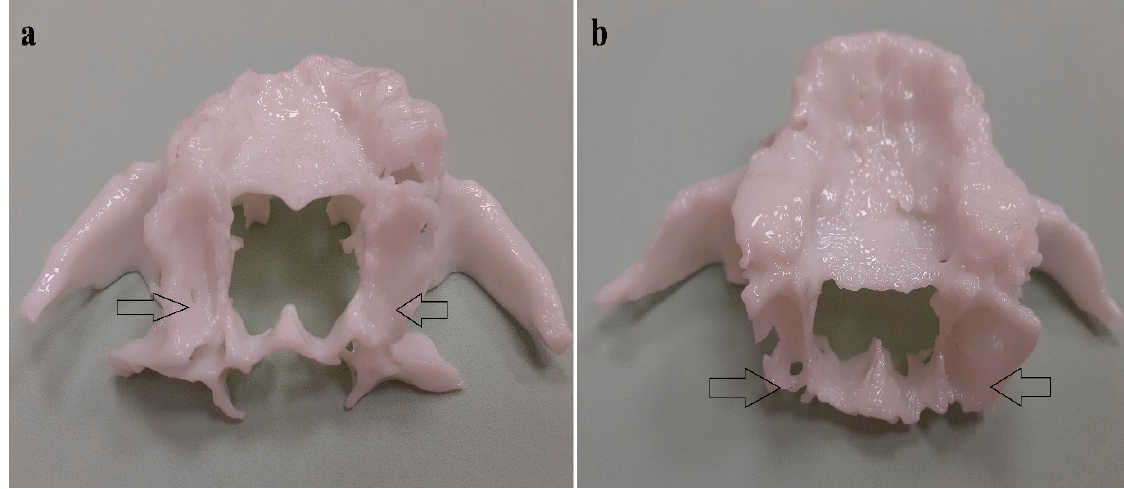
Figure 3. 3D models of the upper jaw with the visualization of the junction zone. ( a ) 3D model of the male upper jaw; ( b ) 3D model of the female upper jaw.